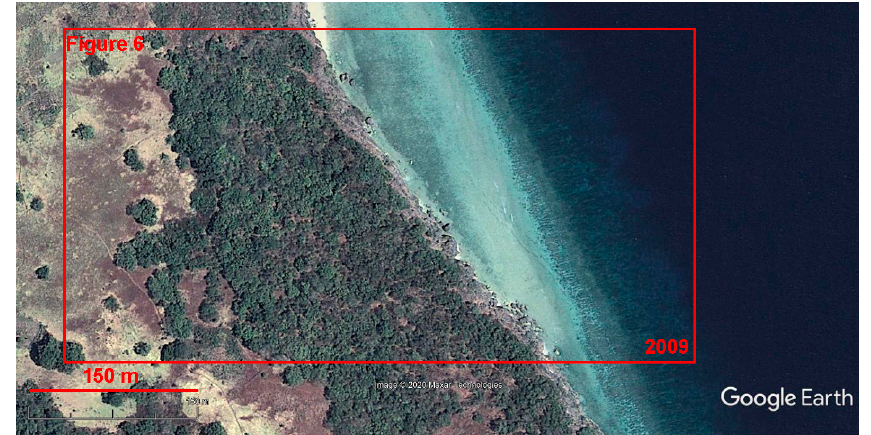
Figure 12. Satellite view of the northwestern plot of the Ponza Island locality in 2009 (the view provided by the Google Earth Engine). J. Mar. Sci. Eng. 2020 , 8 , x FOR PEER REVIEW